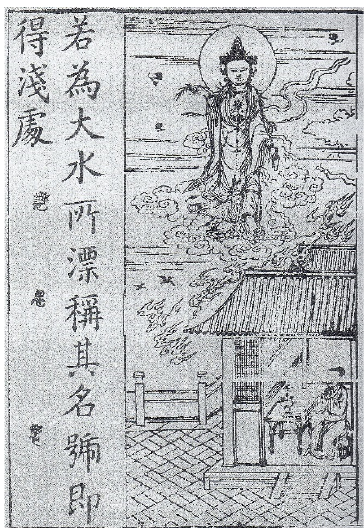
Figure 13. Universal Gate Chapter on Avalokitesvara, Ming dynasty 28th year of Hongwu (1395), 27.6 × 18.8 cm, National Library of China (Weng and Li 2014, vol. 5, p. 40).